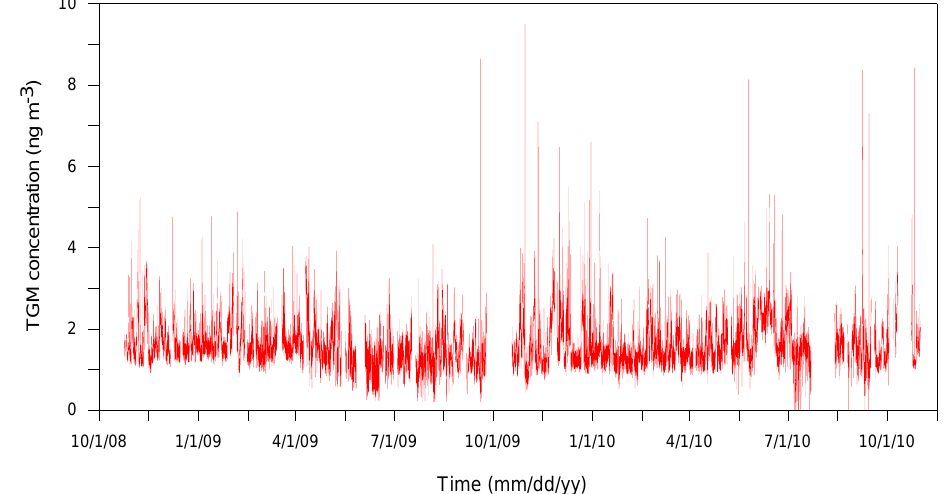
Fig. 2. Time series of 5-min averaged TGM concentrations at